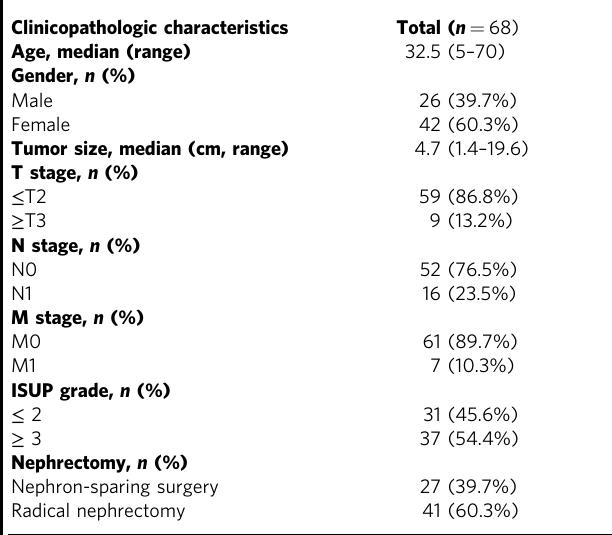
Table 1 Baseline clinicopathologic characteristics of patients with TFE3